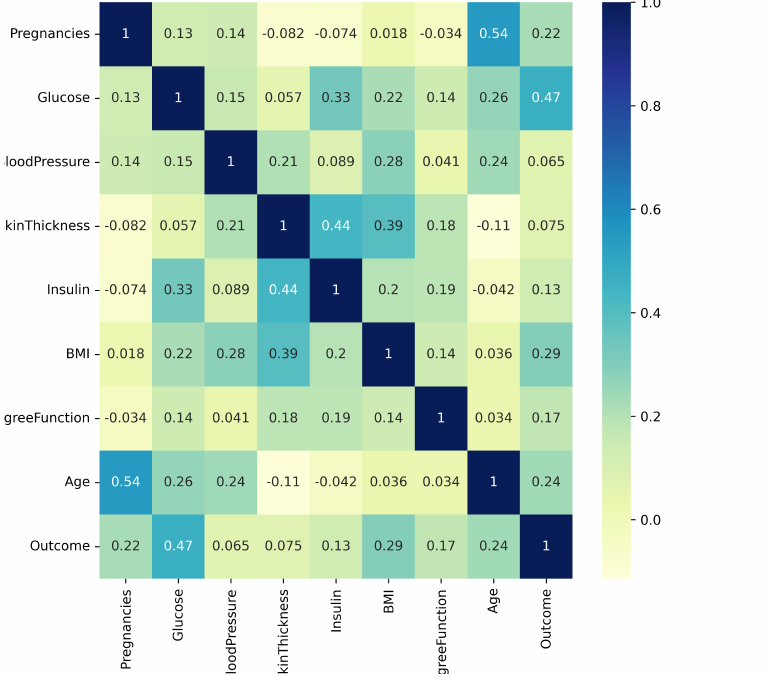
Figure 3. Correlation between the features. Table 4. Missing values in each